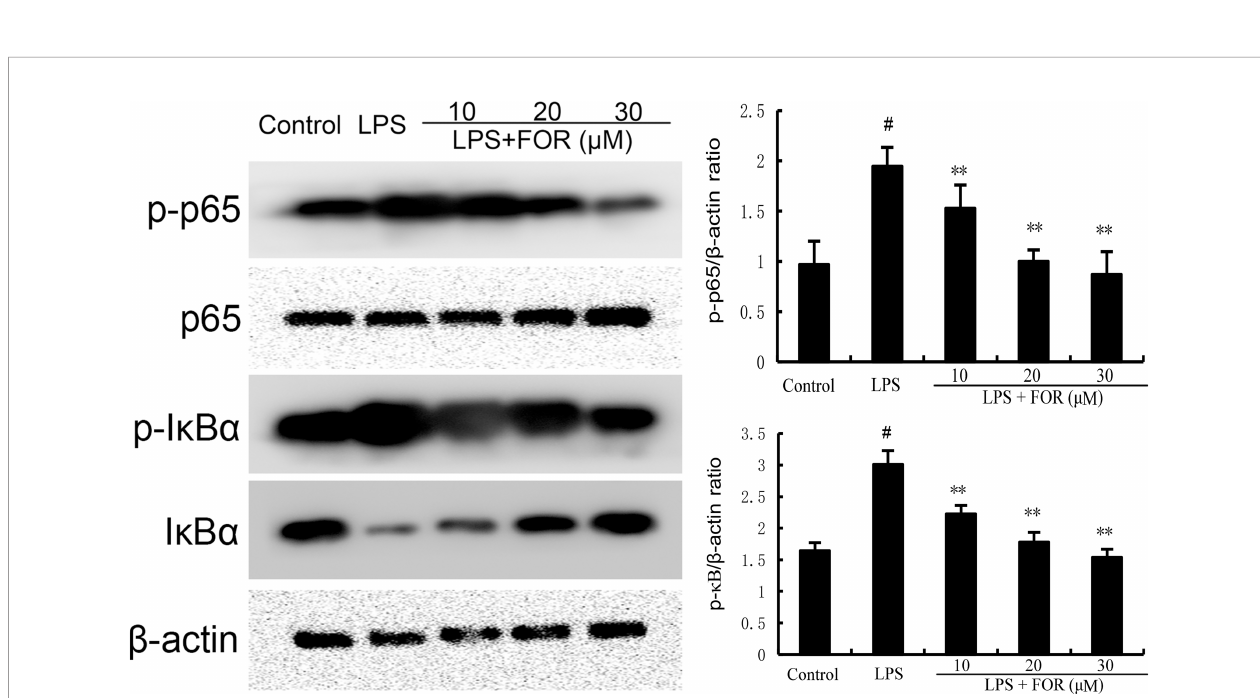
FIGURE 7 | FOR inhibits LPS-induced NF- k B activation. The present results are displayed as the mean ± SEM of triple parallel measurements. # ( P < 0.01) is signi fi cantly different from control group; **( P < 0.01) is signi fi cantly different from LPS group.